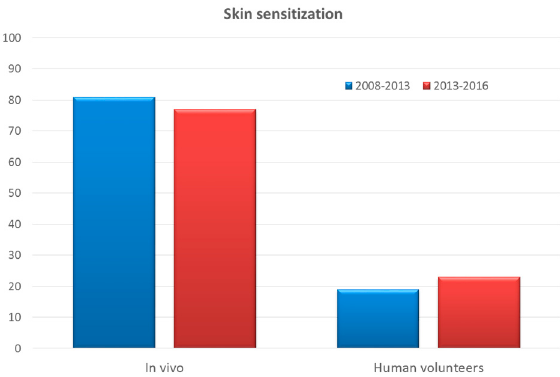
Figure 3. Evolution of the percentage of studies performed in vivo and, in human volunteers to evaluate potential skin sensitization of cosmetic ingredients—number of studies 87 (2008–2013) and 48 (2013–2016).